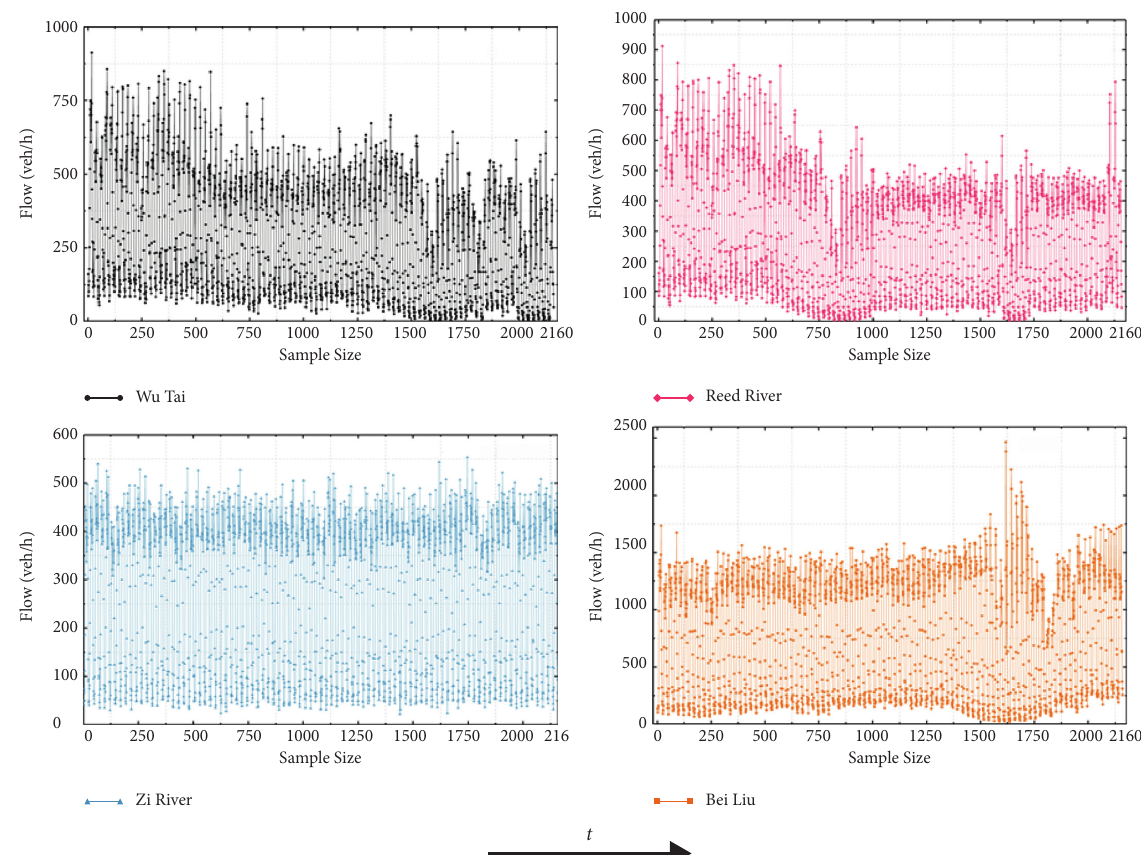
Figure 7: Traffic flow raw data from four monitoring